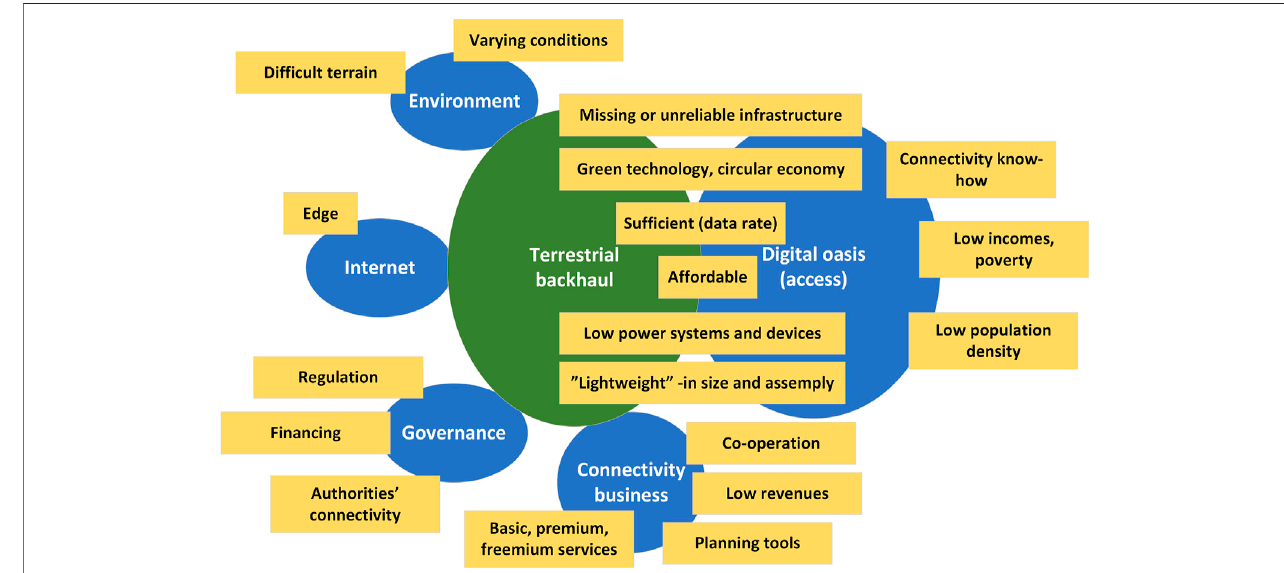
FIGURE 1 | Challenges in 6G backhaul solutions for connecting the unconnected digital oasis.